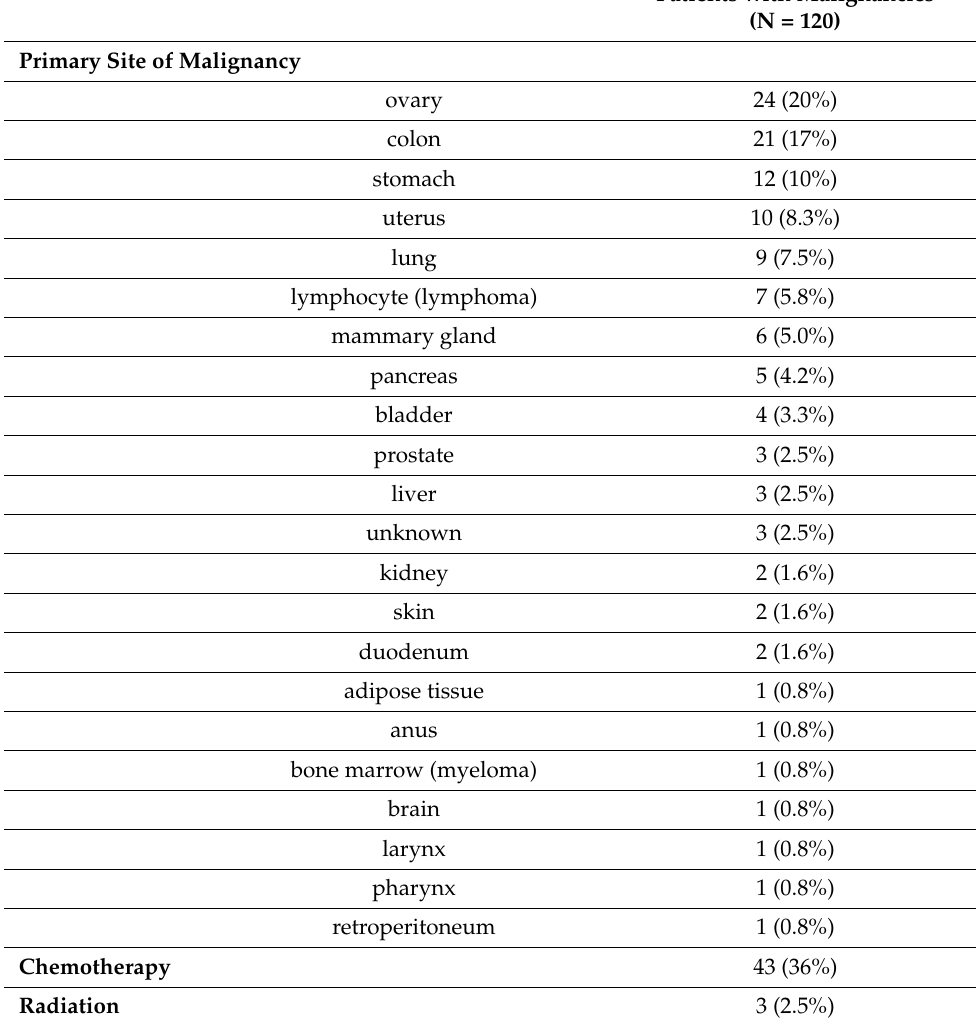
Table 1. The details of malignancies.